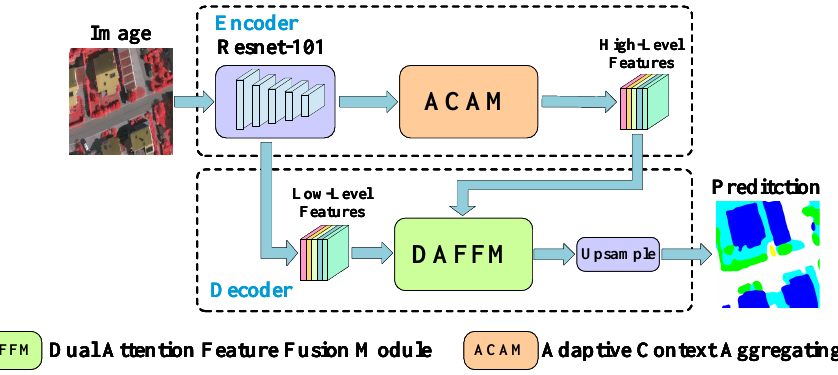
Figure 1. Overview of the proposed network for semantic segmentation of remote sensing